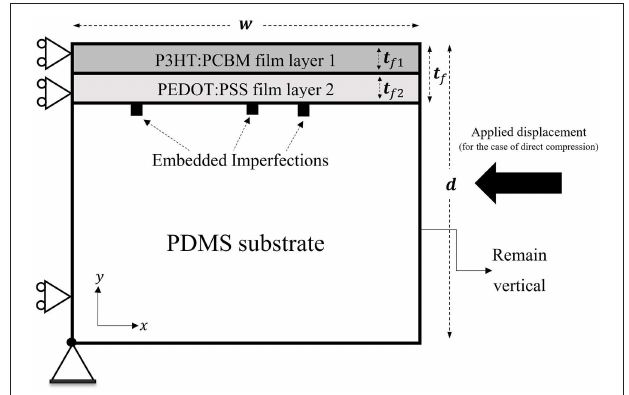
FIGURE 2 | The bilayer film-substrate system and boundary conditions used for the numerical simulations. (Note that for the case of indirect compression, a tensile displacement is applied in the z